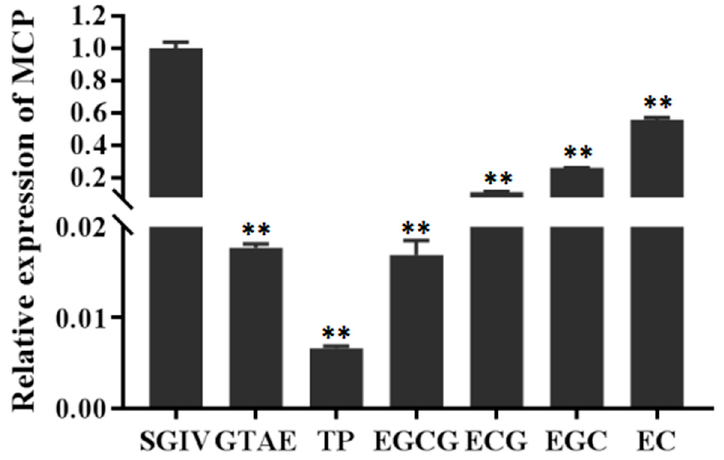
Figure 3. RT qPCR was used to analyze the antiviral effects of green tea components. ** indicates p < 0.01.